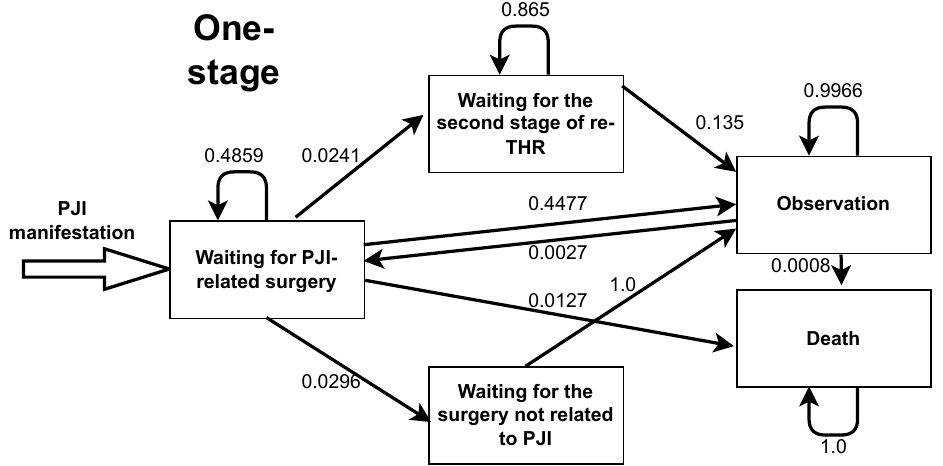
Figure A6. Markov model transition probabilities for one-stage total hip